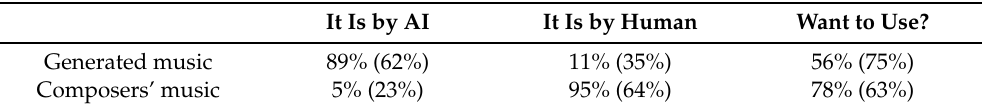
Table 2. Audience’s distinction between the two kinds of music and their willingness to use the generated music as background music (the percentages in the table represent how recognizable the music generated by the model was when voted by the expert group and those in brackets were from people with no musical background.) It Is by AI It Is by Human Want to Use? Generated